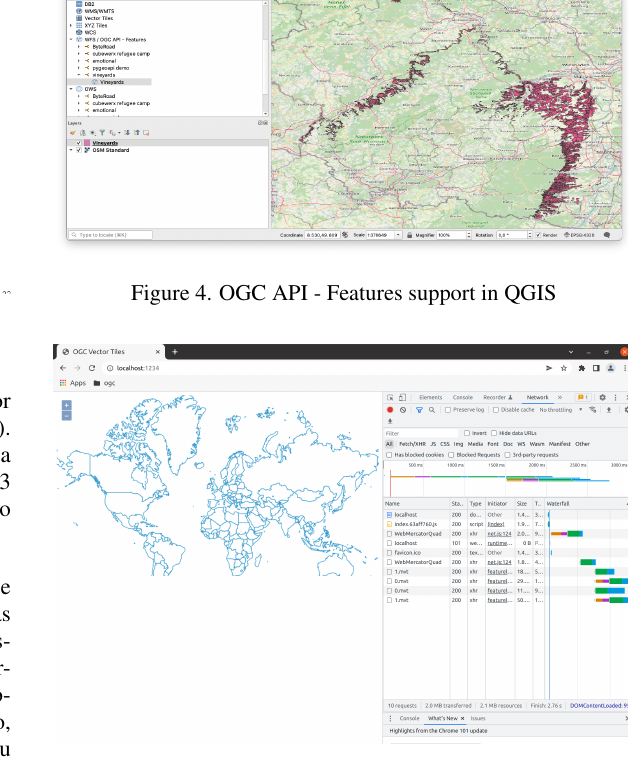
Figure 5. A basic implementation using OGC API - Tiles with